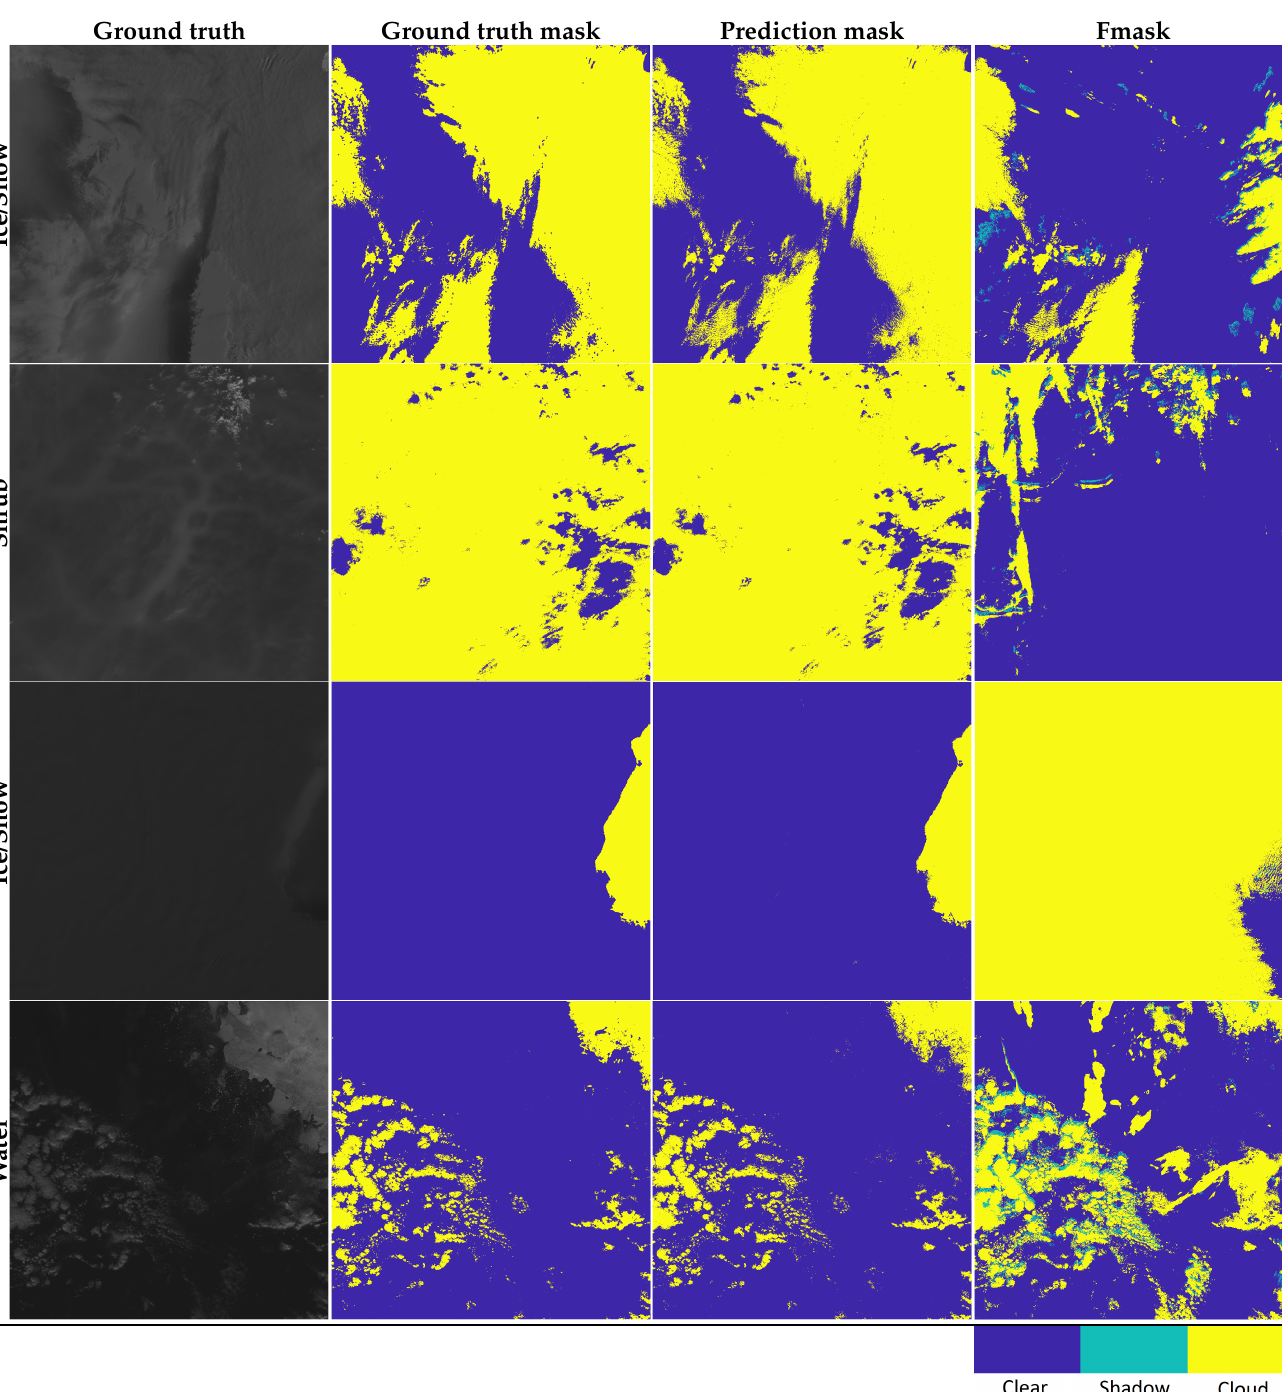
Figure 6. Fmask miss-classified images. Each row displays an image with a certain type. The first column represents the ground truth image and the second column represents the ground truth mask. The third column represents the model prediction results and the fourth column displays the Fmask application